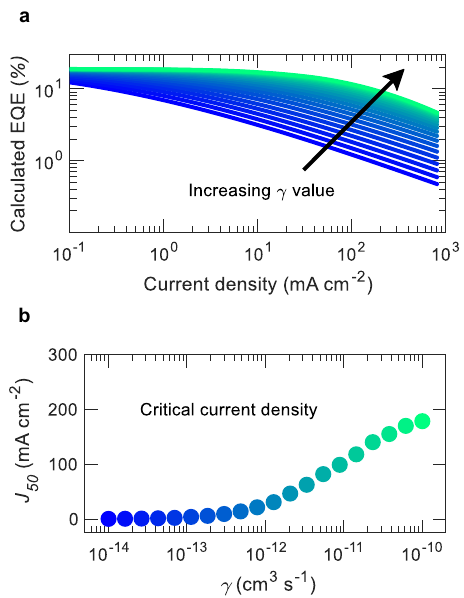
Fig. 7 Impact of γ in EQE roll-off. a Calculated EQE for different γ values. b Critical current density J 50 for each γ